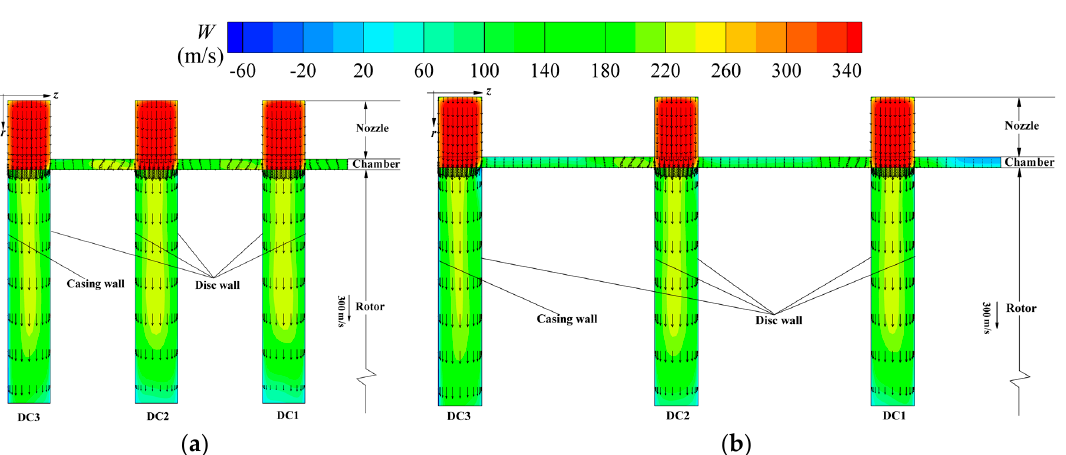
( c ) Figure 8. Mach number contours and streamlines on the mid-sections of three DCs for the one-to-one turbine Case 2-0.5 at 30,000 r/min: ( a ) DC1; ( b ) DC2; and ( c ) DC3. The flow fields for turbine Cases 1-0.5 and 2-0.5 are almost the same in most regions on the radial cross-section. However, the flow velocity of the working fluid in the N-R chamber for turbine Case 2-0.5 is much lower than that for Case 1-0.5, which consumes more extra energy to move them.